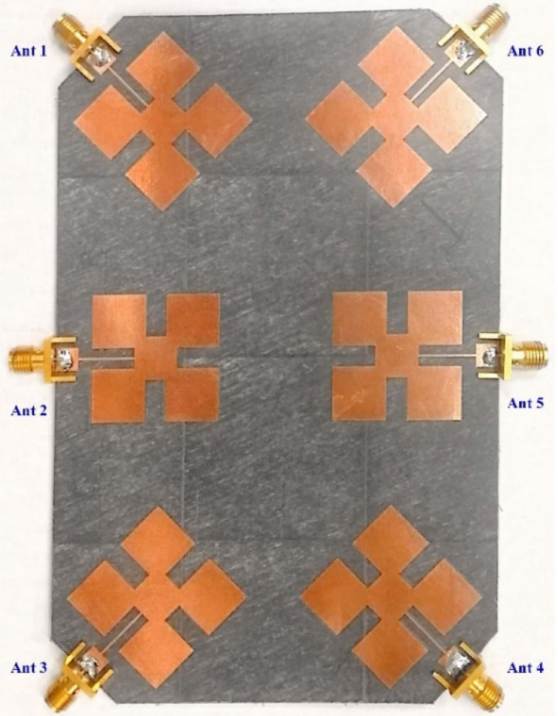
Figure 6. Photograph of the fully grounded proposed MIMO antenna array.